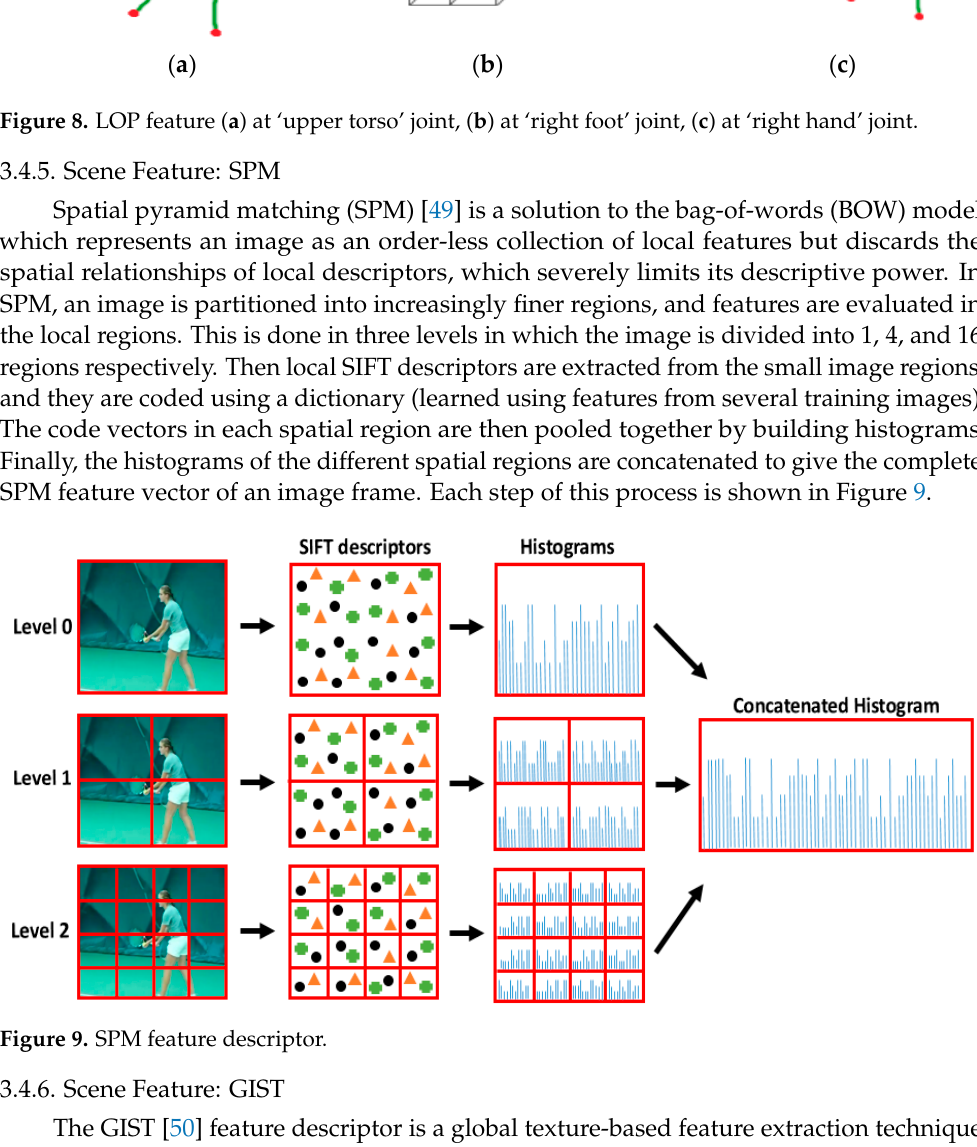
Figure 8. LOP feature ( a ) at ‘upper torso’ joint, ( b ) at ‘right foot’ joint, ( c ) at ‘right hand’ joint.